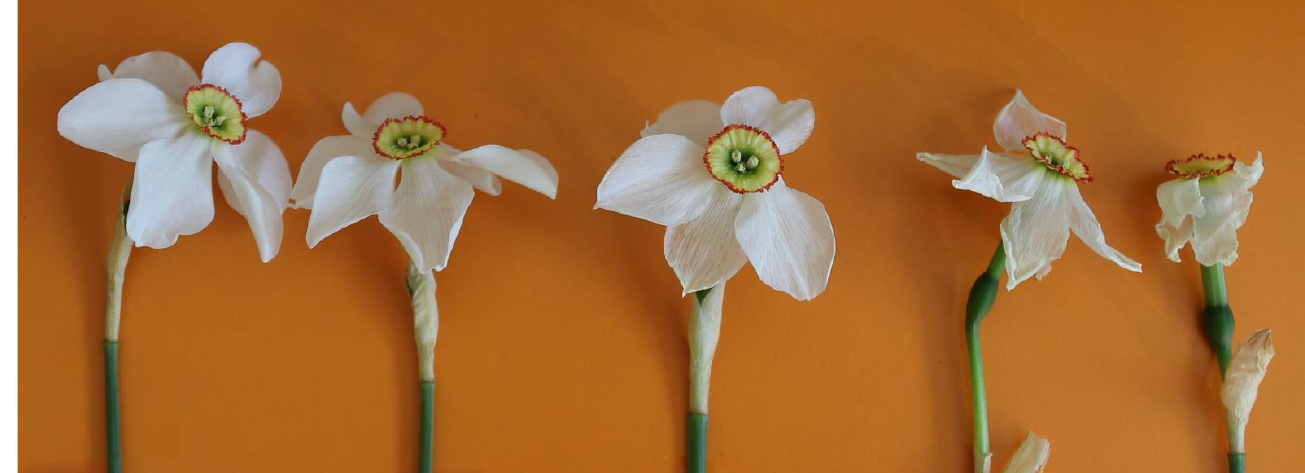
Figure 4. Senescence degree of flowers (from the left: the first two plants are fully open (FO); middle: AF1 — all tepals become membranous but keep their turgor; next: AF2 — the tepals start to gather, the corona still keeps its color and turgor; AF3 — the tepals are shriveled, total wilting).